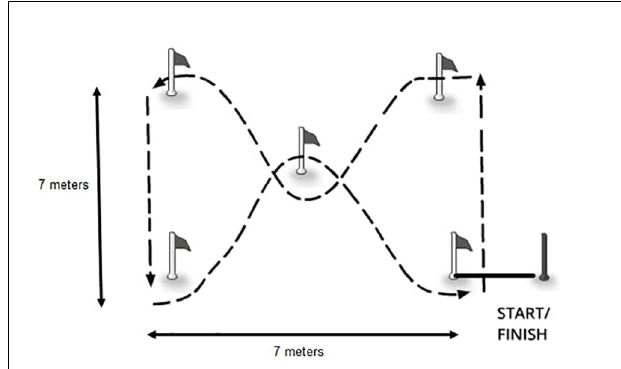
FIGURE 1 | Zigzag agility